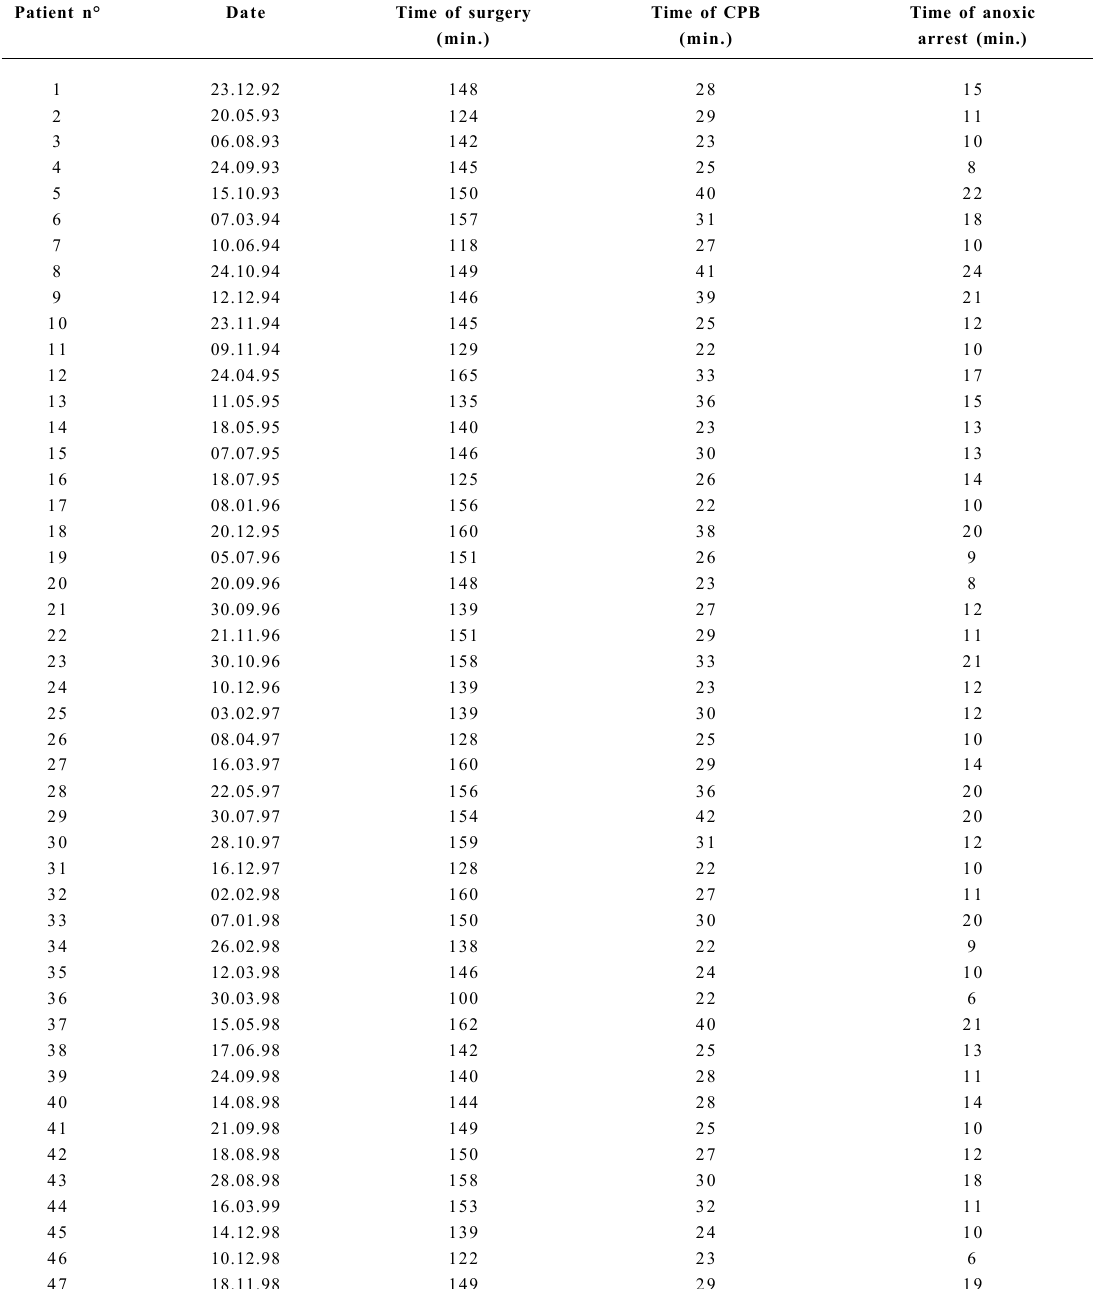
CPB = cardiopulmonary bypass; min. =